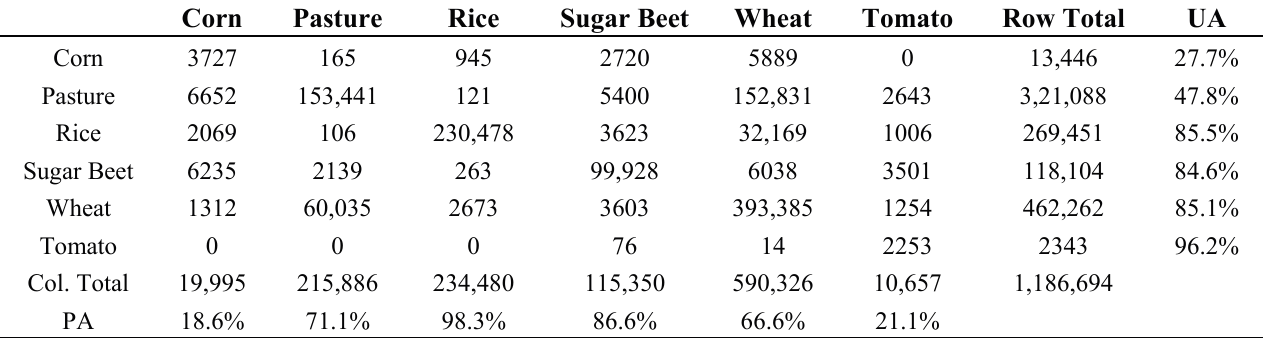
Figure 10. ( a ) Kompsat-2 June test image (RGB, 2721 × 2258 pixels, acquired on 13 June 2008), and the ( b ) reference map. Thematic output maps of, ( c ) SVM without smoothing, ( d ) SVM-LCS, ( e ) SVM-ECS, and ( f ) parcel-based strategy with SVM without smoothing. Table 4. Confusion matrix of SVM-ECS classification for Kompsat-2 June test image. Corn Pasture Rice Sugar Beet